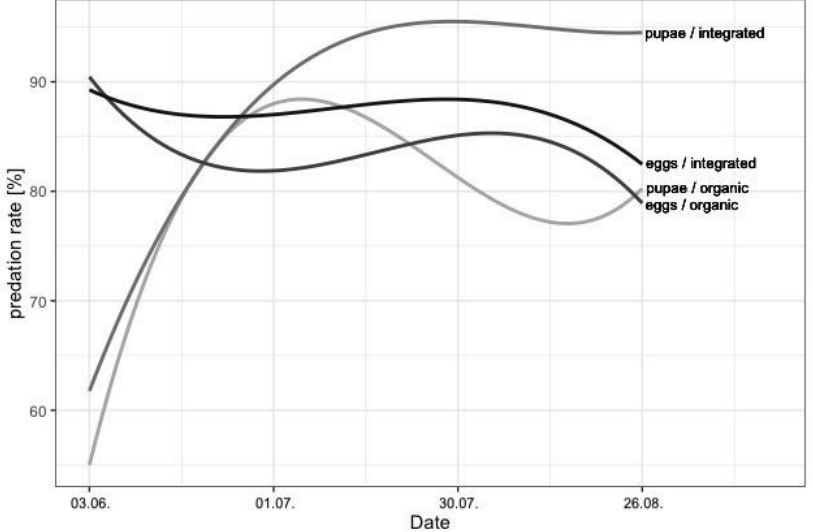
Figure 3. Mean predation rates of L. botrana pupae and eggs in organic and integrated vineyards for four sampling dates (3 June 2019, 1 July 2019, 30 July 2019, 26 August 2019).